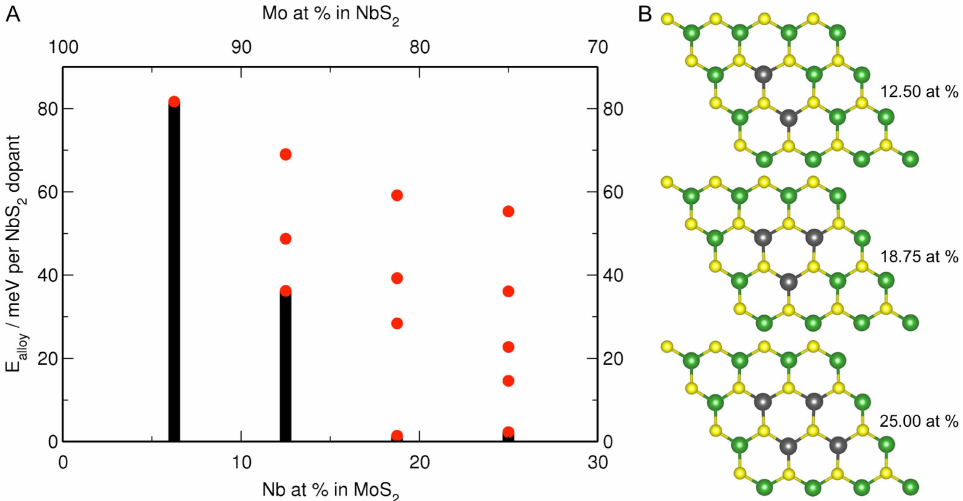
Figure 7. ( A ) The alloying energies (E alloy , in meV per NbS 2 unit) of the Mo 1 ´ x Nb x S 2 systems and ( B ) selected alloys with the most stable Nb arrangement for a given concentration. Green, Mo; grey, Nb; yellow, S.